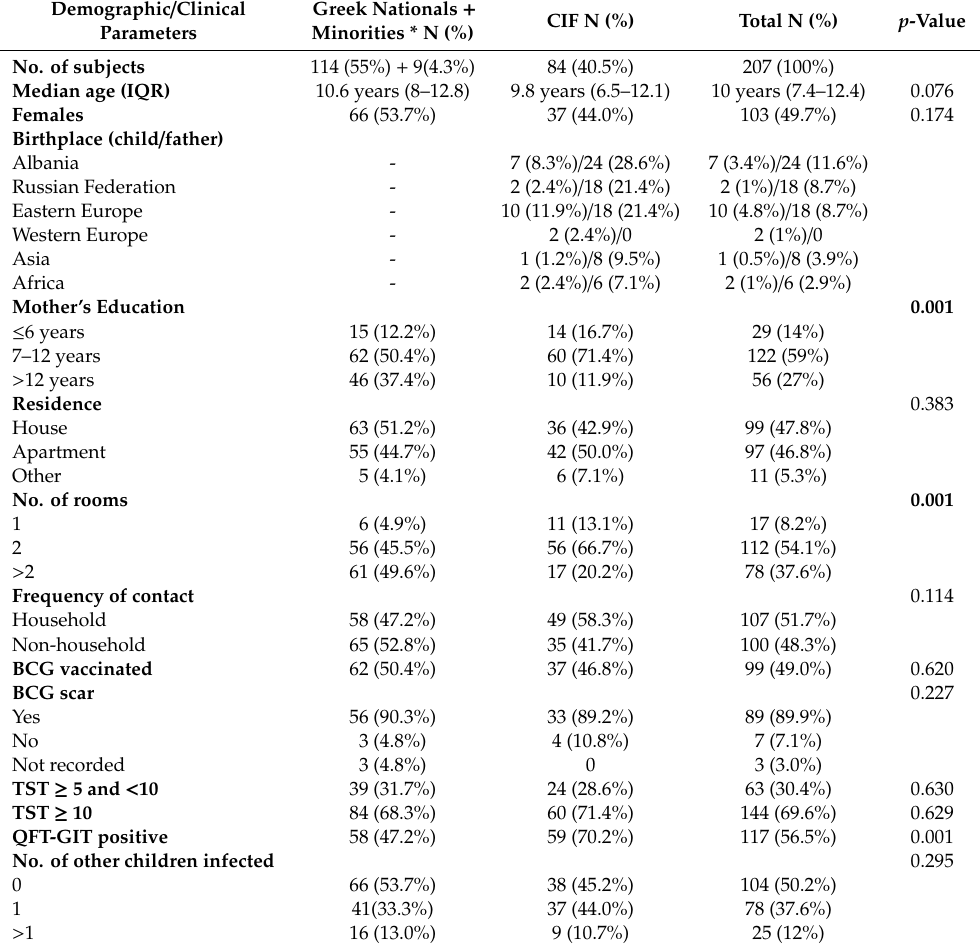
Table 1. Demographic and clinical characteristics of subjects enrolled (N =